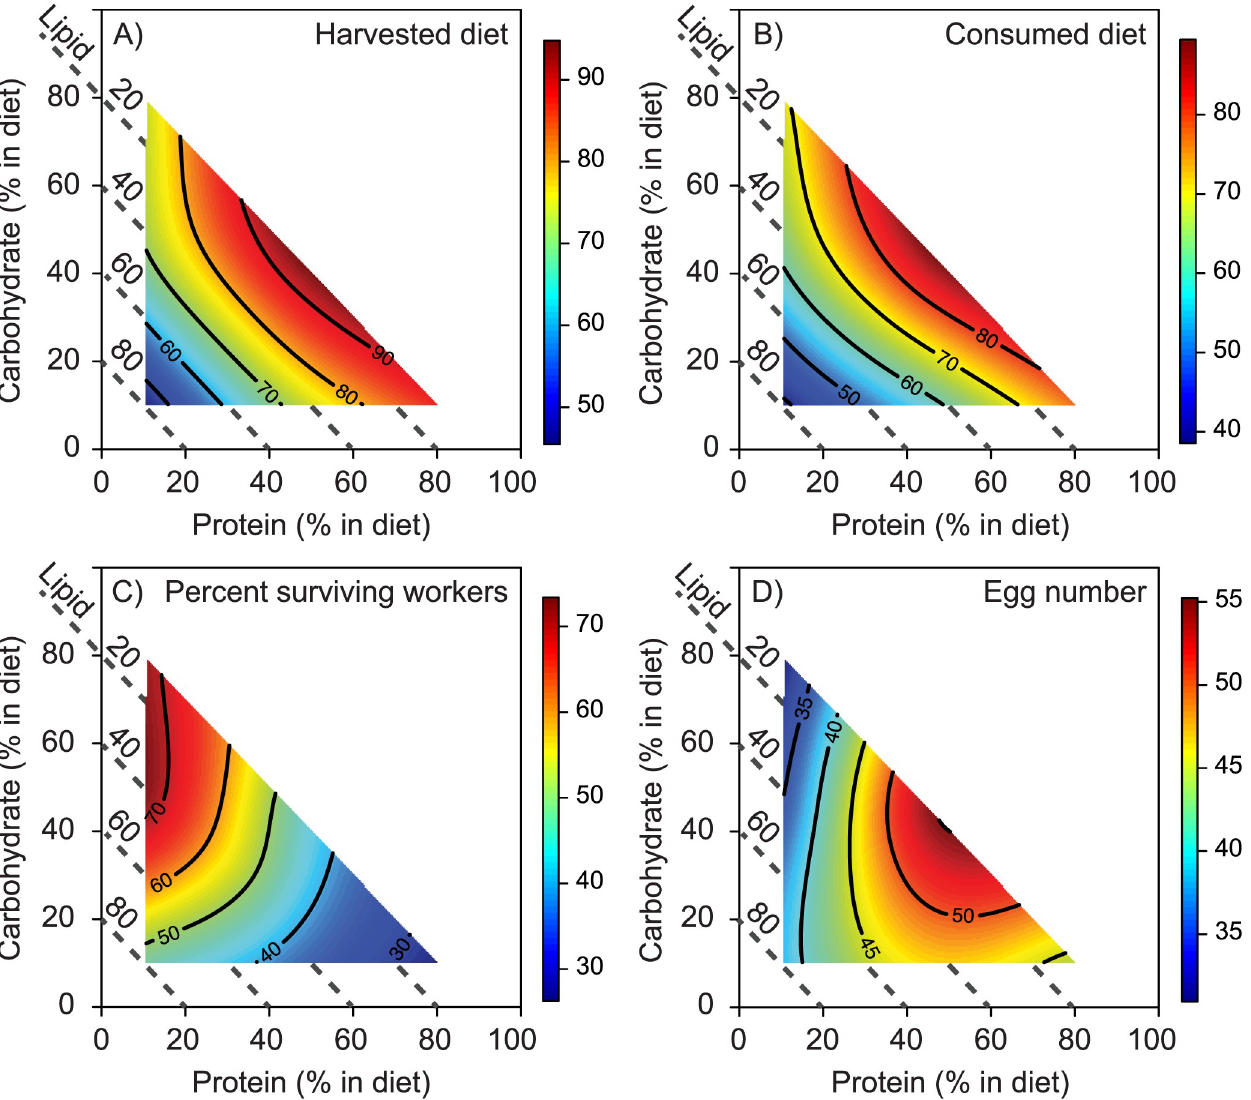
Fig 4. Nutritional landscapes visualize the fundamental macronutrient niche (FMN) of M . pharaonis in three dimensions (proteins, carbohydrates, and lipids; P:C:L). (A) Colonies harvested maximal amounts across a broad range of protein-biased and carbohydrate-biased diets, while avoiding lipid- biased diets. (B) Colonies consumed most of the diet they harvested regardless of the P:C:L content. (C) The survival percentage of adult workers was highest on diets with moderate to high carbohydrates, low protein and low to moderate lipids. In contrast, moderate to high amounts of protein yielded the lowest worker survival, even as carbohydrates and lipids increased. (D) Colonies produced the most eggs when colonies were confined to diets with similar levels of protein and carbohydrates and low lipid content, and the fewest eggs on all diets where protein availability was low, regardless of carbohydrate and lipid amounts. Isoclines (red areas are highest values and blue areas are lowest) indicate dry mass of diet (mg), percent worker survival, or egg numbers, with scale bars adjusted relative to the range of observed values. Landscapes comprise 7 P:C:L ratios ( see Fig 1C) and diet percentages (axis labels) indicate energy content provided by each macronutrient, with total energy content available standardized across diets (see Methods). Response surface regressions underlying colored heat maps were significant in each panel (Table 1).